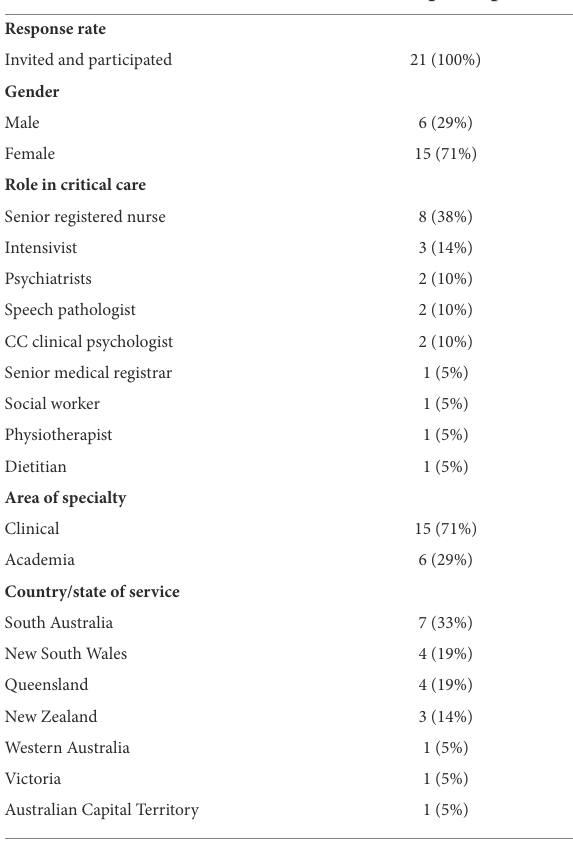
TABLE 1 Demographics and professional characteristics pf participant’s current